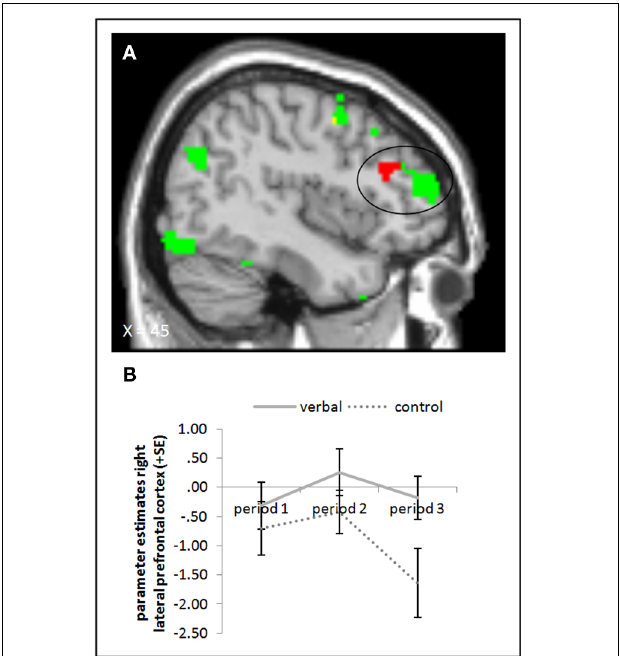
FIGURE 5 | (A) Activation for picture presentation was significantly higher in the right lateral prefrontal cortex in the monetary reward group compared to the control group in period 3 (whole brain uncorrected, p < 0 . 001, only clusters with a minimum of 10 activated voxels are shown; small volume corrected, p FWE < 0.05). Activation clusters without baseline correction are shown in green, clusters with baseline correction are shown in red, activation overlaps are shown in yellow. (B) Parameter estimates are displayed for illustration.